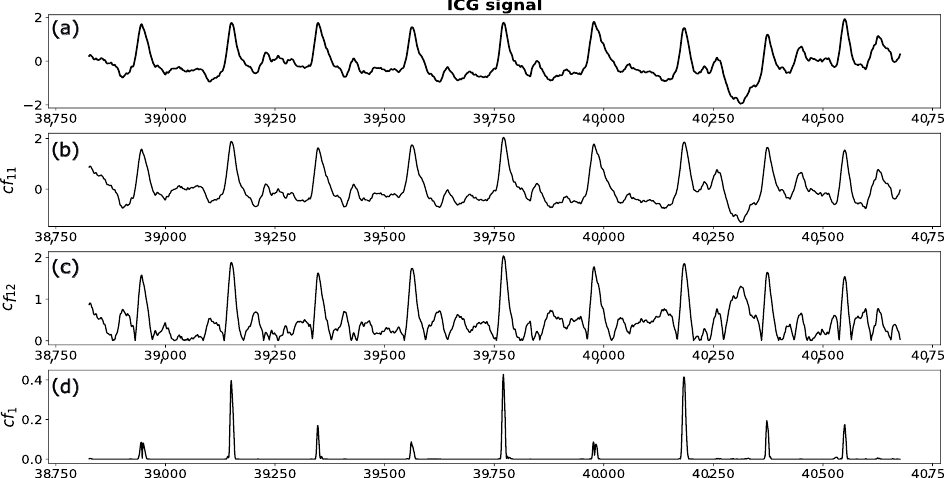
Figure 5. The upper figure ( a ) represents a fragment of an ICG signal. Panel ( b ) illustrates the function cf 11 , representing the sum of the first four intrinsic mode functions (IMFs) resulting from EMD of the signal presented in panel ( a ). Panel ( c ) shows the function cf 12 defined as the product of first three IMFs. In the lower panel ( d ), the product of the signals ( b , c ) is depicted. Then, by taking the absolute value of this